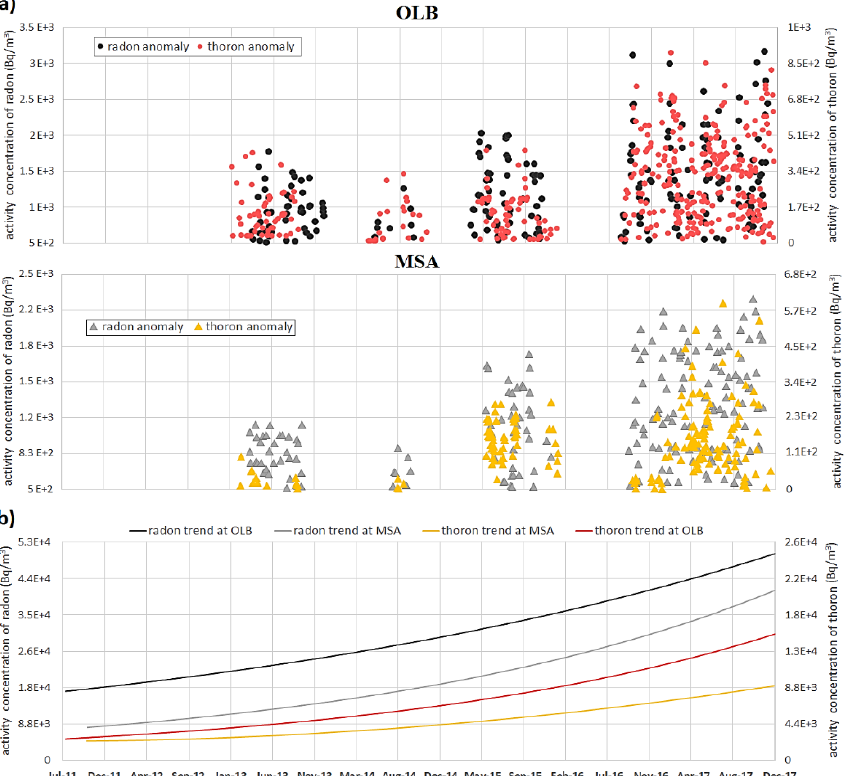
Figure 3. ( a ) Anomalies of 222−220 Rn at OLB (first graph) and MSA (second graph) sites, obtained by subtracting the forecasted signals, using hybrid method MLR + EMD + SVR, from the raw recorded data, within a 95% CI. ( b ) Trends in 222−220 Rn at OLB and MSA sites, obtained by applying the MLR + EMD hybrid method. The accuracy of the measured data, i.e., the error bars, is an approximately constant 4%.